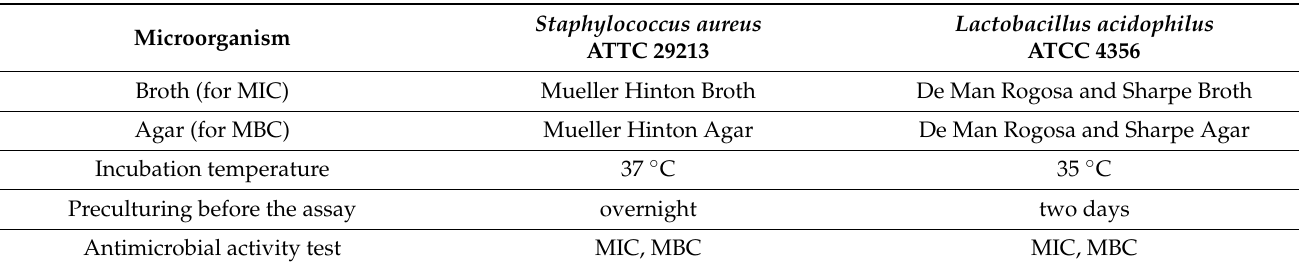
Table 7. List of microorganisms and media included in the experiment. The incubation conditions are also